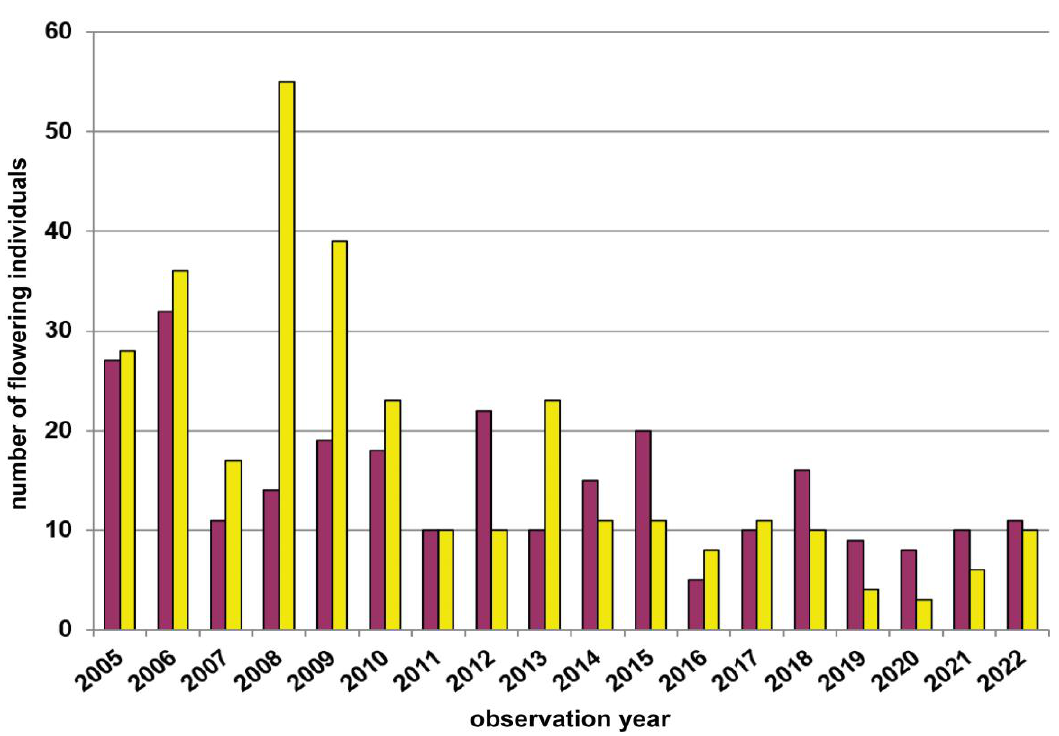
Figure A1. Population census (2005 – 2022) of the Dactylorhiza sambucina -population Leopolds in the Waldviertel region. Red columns = red-flowering plants and yellow columns = yellow-flowering plants.